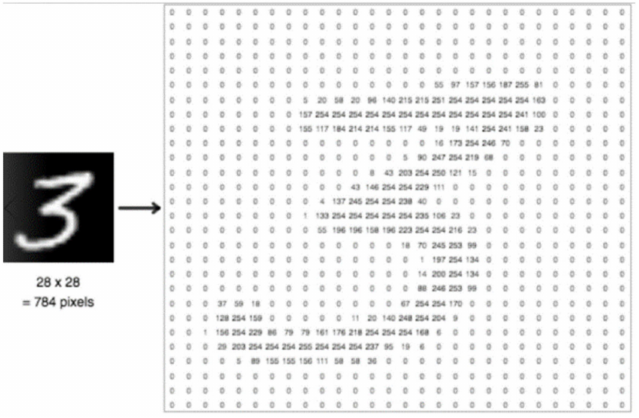
Figure 9. Image representation. The NumPy “astype” method was used to convert pixel values into double. This method converted each image into a double precision number. The images’ pixel values were normalized using a min–max normalized method. After achieving the minimum and maximum values of the pixels, each image was normalized by traversing its pixel value using Equation (1).